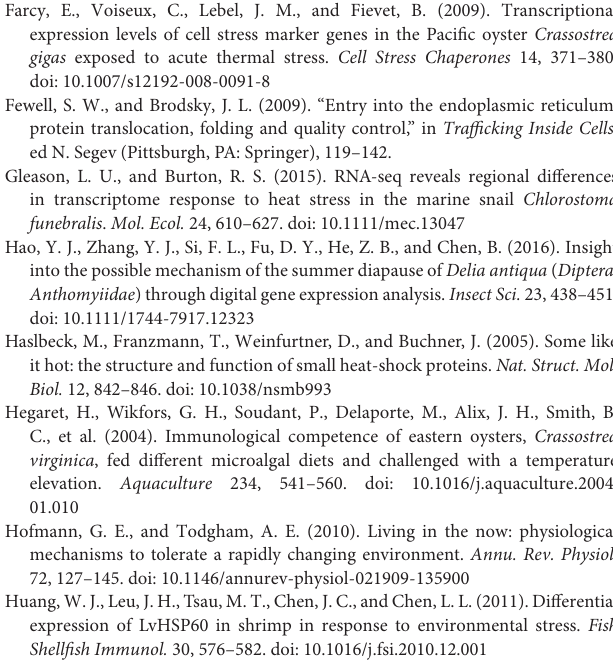
(A) Thermal stress and (B) Control mapped to the reference sequences. Figure S2 | (A) Saturation analysis of the clean reads obtained from the thermal stress library. The number of genes increases rapidly with the number of clean reads until 1.5 million reads are sampled, with the total number of newly found genes plateauing at approximately 6 million reads. (B) Same relationship between number of genes and reads sampled as shown in (A) are observed in case of the control library. Figure S3 | Percentage of reads mapping to the genes for the (A) thermal stress library and (B) the control library. As evidenced here, more than 50% of the genes are covered by high read